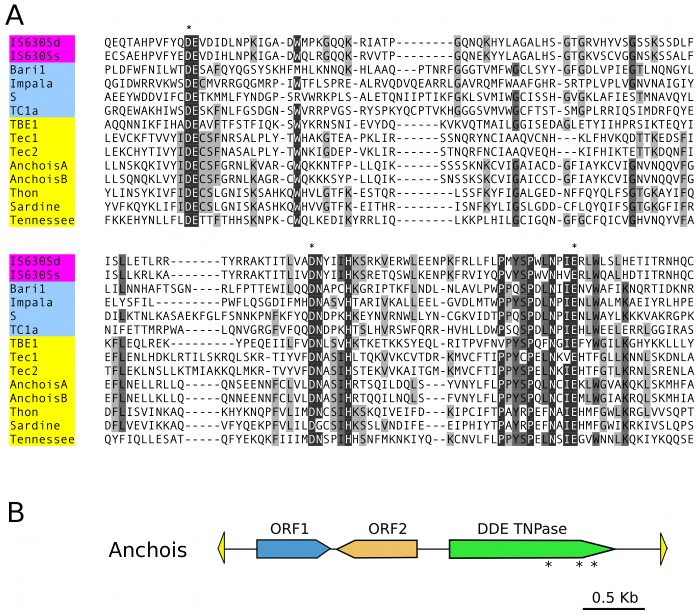

Anchois Tc1/mariner family transposon.A) Alignment of the DDE domains of bacterial IS630 elements (IS630Sd, Salmonella dublin, GenBank Accession No. A43586; IS630Ss, Shigella sonnei, X05955), invertebrate and fungal Tc1 transposons (Baril, D melanogaster, Q24258; Impala, Fusarium oxysporum, AF282722; S, D melanogaster, U33463; Tc1, C elegans, X01005) and ciliate Tc1/mariner transposons (TBE1, Oxytricha fallax, L23169; Tec1 and Tec2, Euplotes crassus, L03359 and L03360; Anchois, Thon and Sardine, Paramecium tetraurelia, this article; Tennessee, Paramecium primaurelia, [34]). Asterisks mark the conserved catalytic DDE residues. B) Schematic diagram of the 3.6 Kb Anchois consensus, showing the position and orientation of the 3 ORFs. The yellow triangles represent the ∼22 nt TIRs. Asterisks mark the position of residues of the catalytic DDE triad for the ORF encoding the DDE transposase.